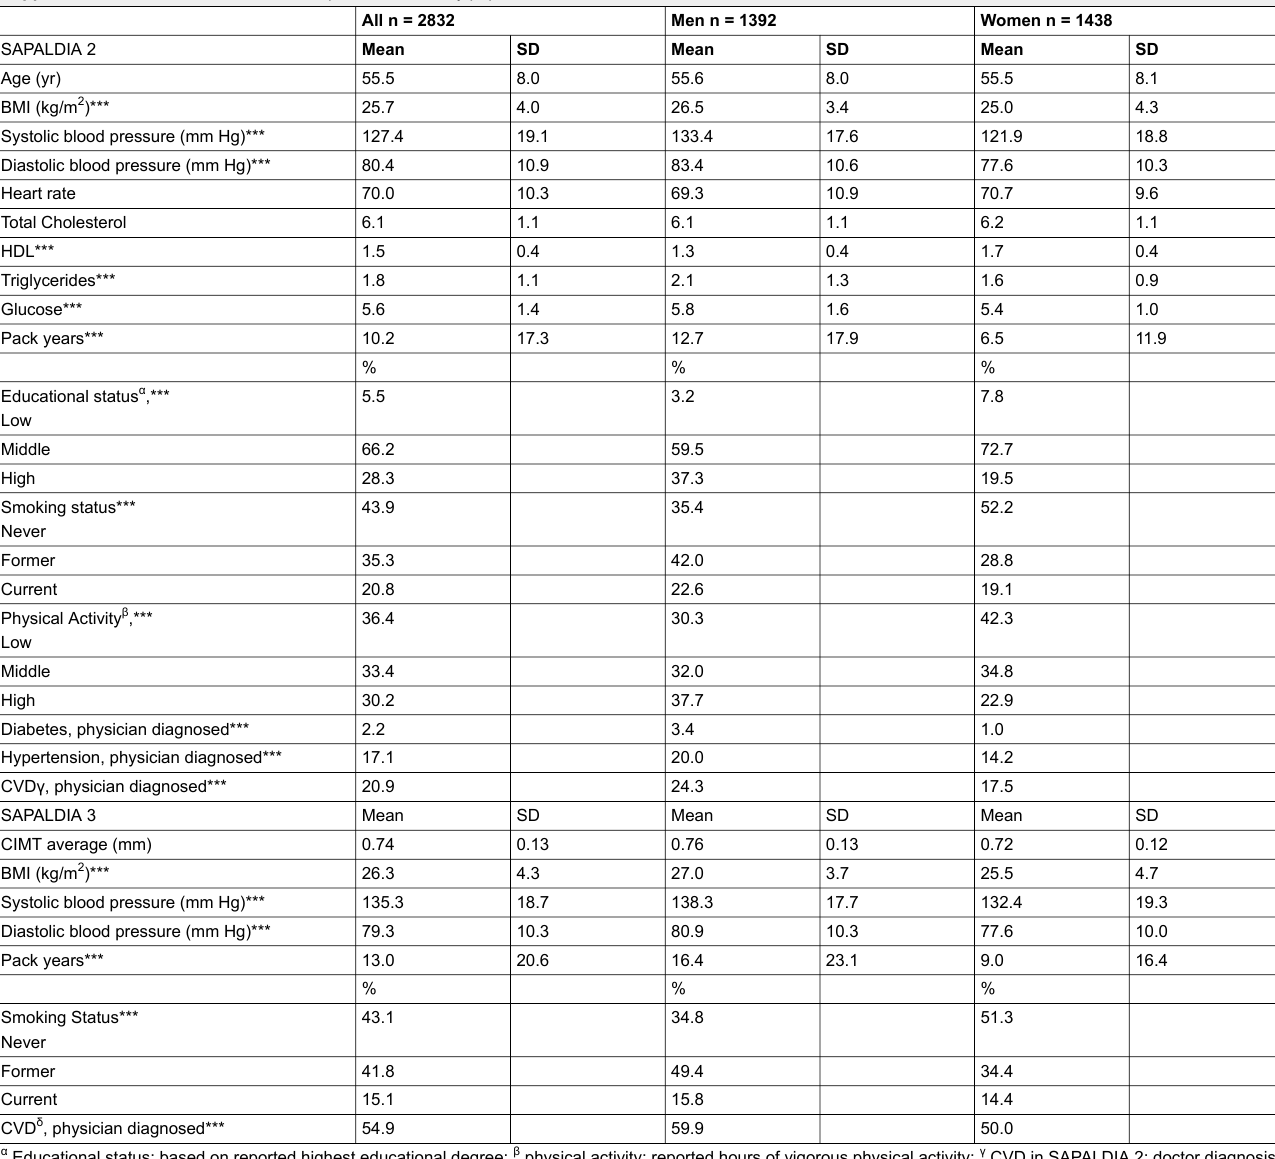
Supplemental table 1: Cardiovascular risk profile in the study population in SAPALDIA 2 and SAPALDIA 3. All n = 2832